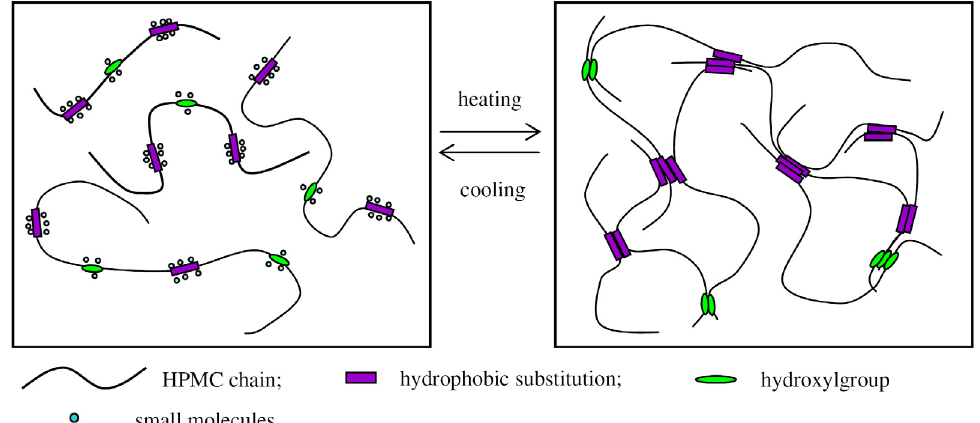
Figure 17. Schematic structures of sol-gel transition of HPMC aqueous solutions with